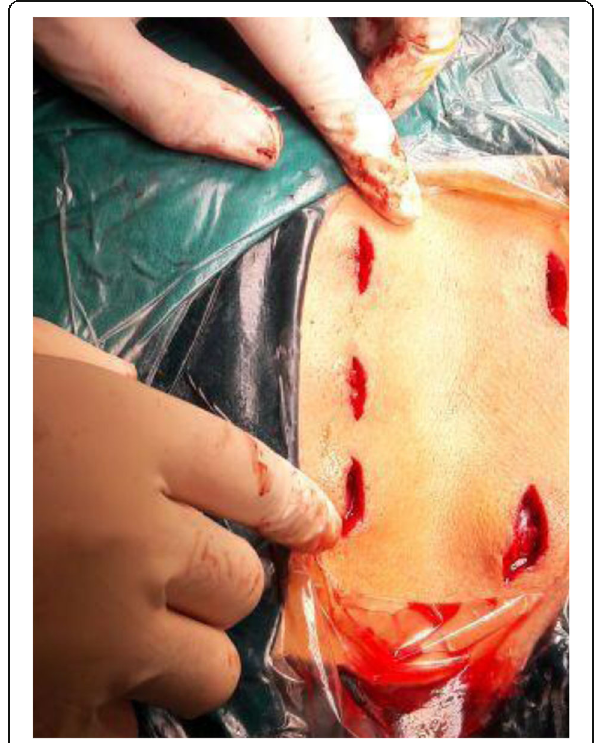
Fig. 4 Skin incisions in a patient planned to undergo percutaneous fixation one level above and one level below with injured level screw on the left side; the right pedicle of the involved level was damaged